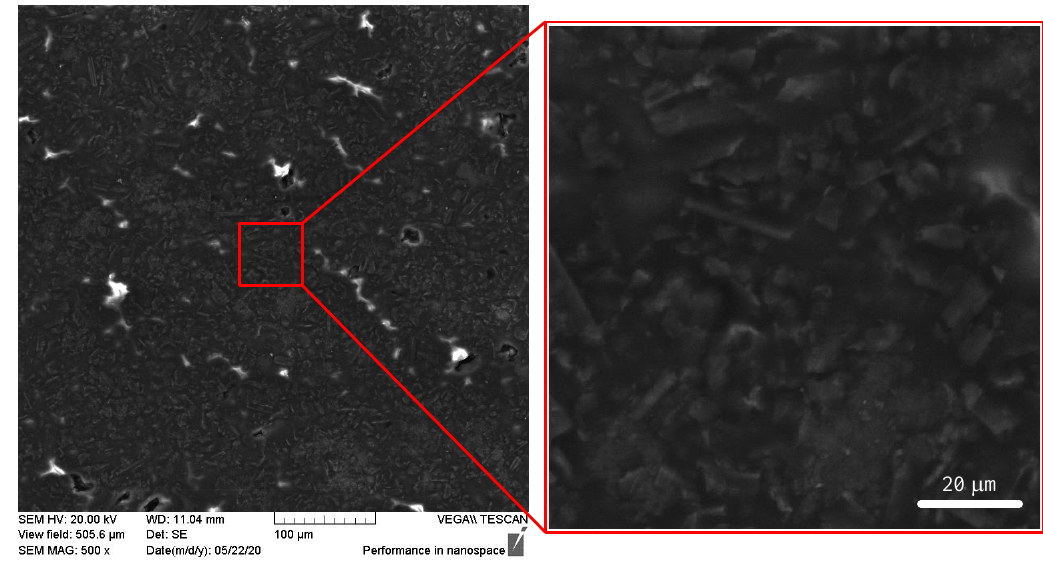
Figure 3. SEM images of the prepared acrylate PTC composite.